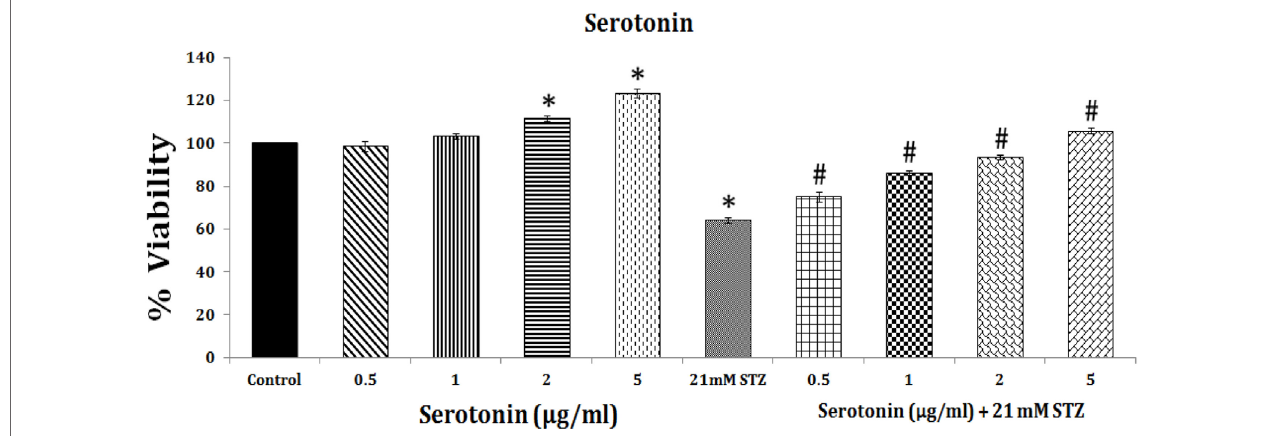
FiGUre 9 | Effect of serotonin on the proliferation of RIN 5F cells in vitro and its modulatory effect on streptozotocin-induced inhibition (apoptosis) of RIN5F